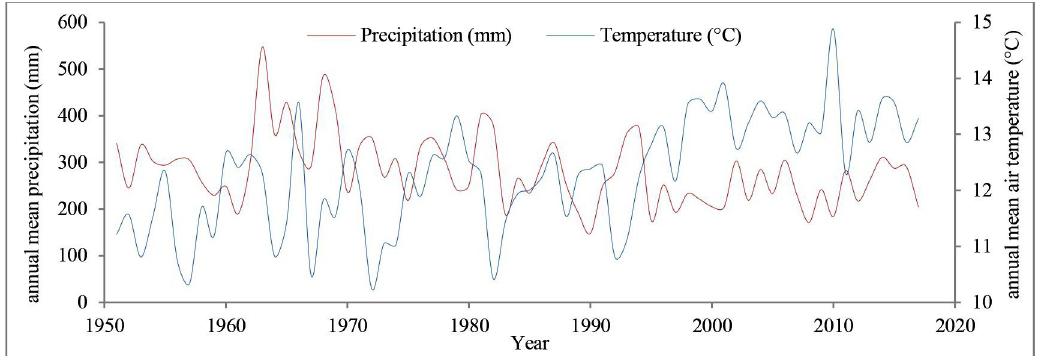
Fig 2. Historical trends in annual mean temperature and precipitation in Tabriz (1951–2017)—(Data source: